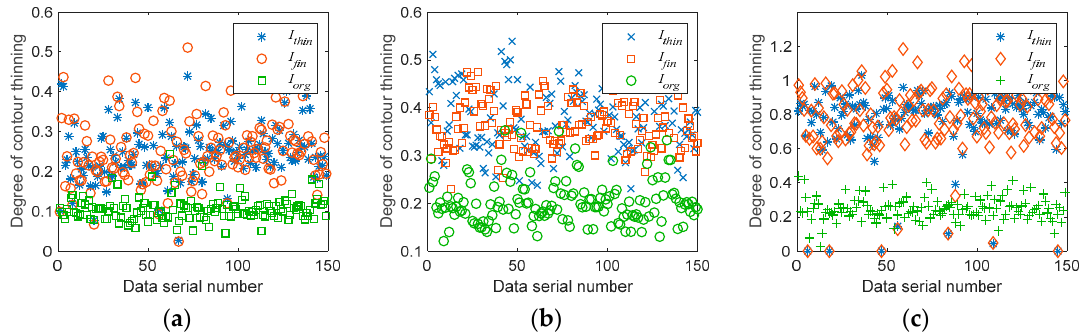
Figure 7. Comparison of contour thinning degree of backprojection imaging ( I org ), contour thinning imaging ( I thin ), and residual compensation imaging ( I fin ): ( a ) 5° aperture imaging; ( b ) 10° aperture imaging; ( c ) Full aperture imaging.